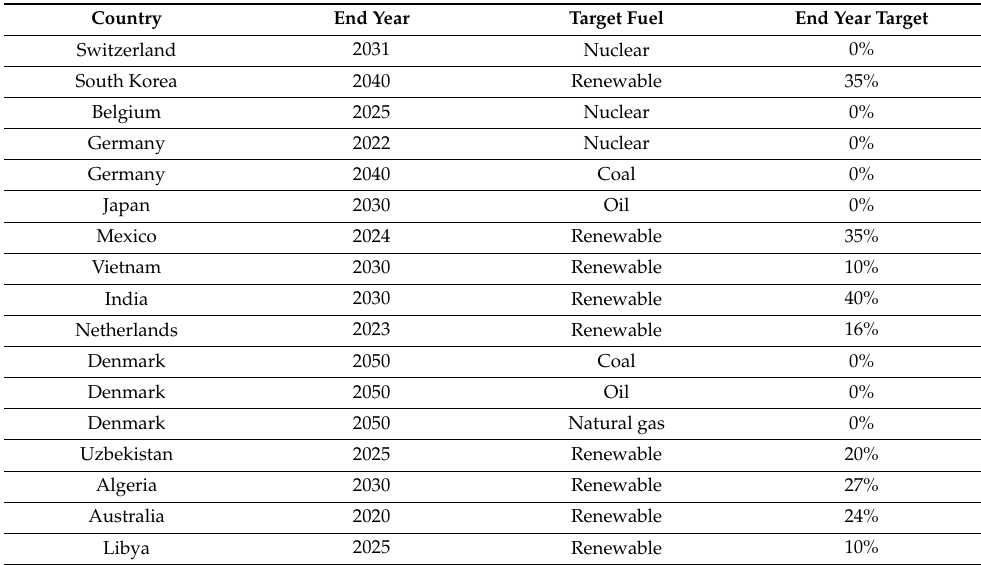
Table 2. By country, energy transition goals and market and generation share targets (the country- level climate targets are updated regularly based on IEA/IRENA Renewables Policies Database).